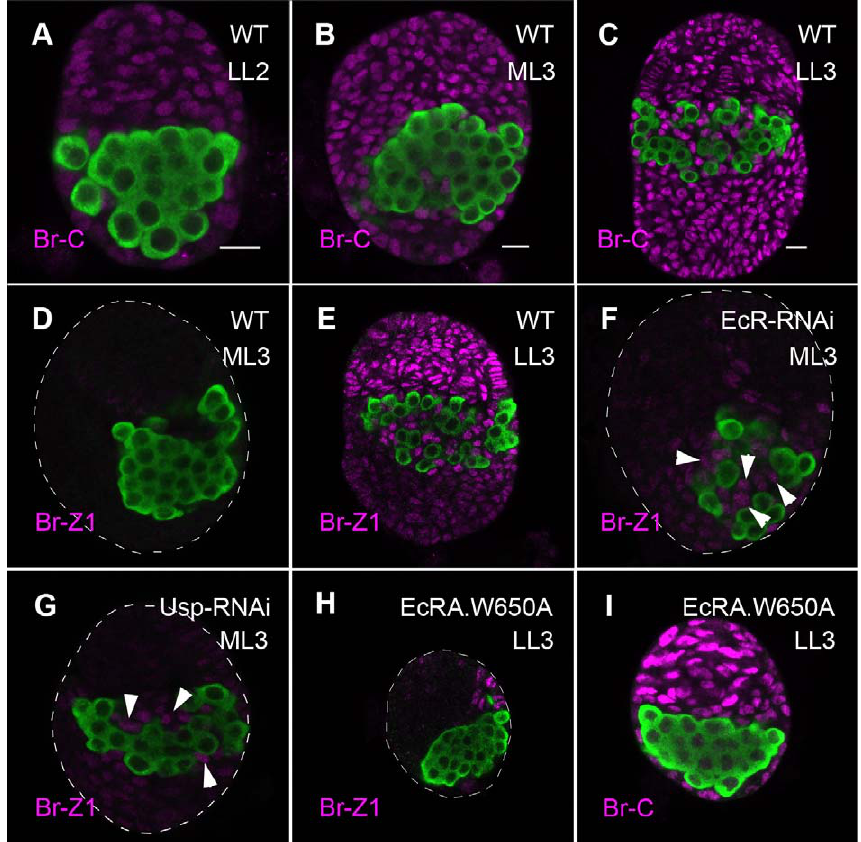
Figure 3. Somatic ecdysone receptors are early repressors and late activators of Broad-Z1. In all panels, germ cells are labeled with anti- Vasa (green). Panels (A–C) were taken with the same confocal settings. Antibodies against the common region of Broad (Broad-C, magenta) stain somatic cell nuclei of LL2 (A), ML3 (B), and LL3 (C) ovaries. Staining levels become stronger with time. Panels (D–G) were taken with the same confocal settings. Broad-Z1 (magenta) is very weakly expressed in wild type ML3 ovaries (D), but is strongly expressed at LL3 (E). In contrast to wild type, Br-Z1 is expressed in ICs (arrowheads) of EcR -RNAi (F) and usp -RNAi (G) ML3 ovaries. (H) Broad-Z1 (magenta) is not expressed in most somatic cells of EcRA.W650A ovaries. (I) In contrast, anti-Br-C does label somatic cells of EcRA.W650A ovaries. Bars in (A), in (B) (for B, D, F, G), and in (C) (C, E, H, I) are 10 m m.